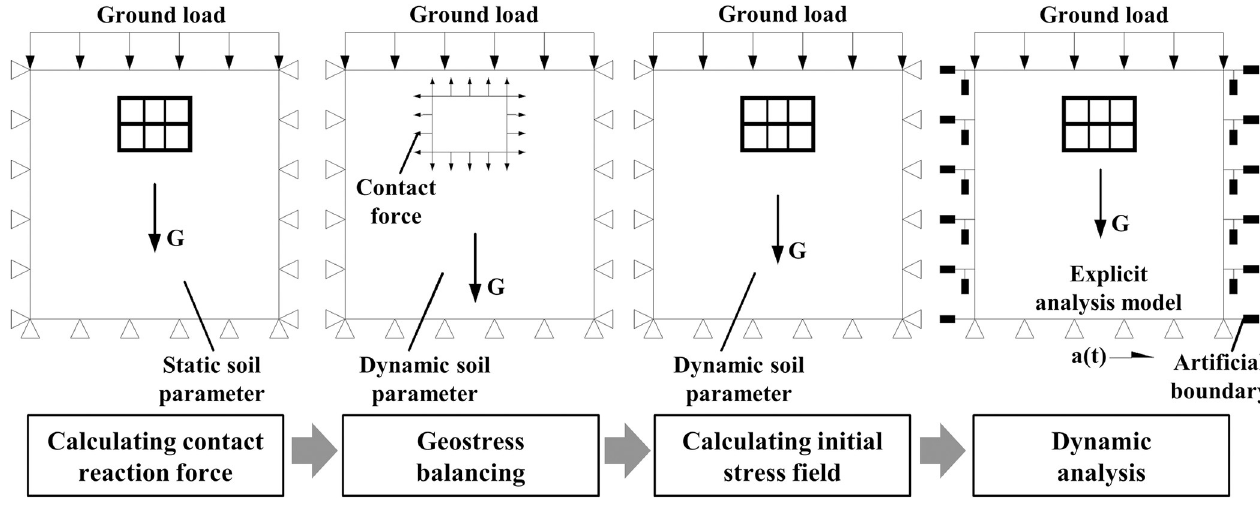
Fig 8. Loads and boundary conditions during the